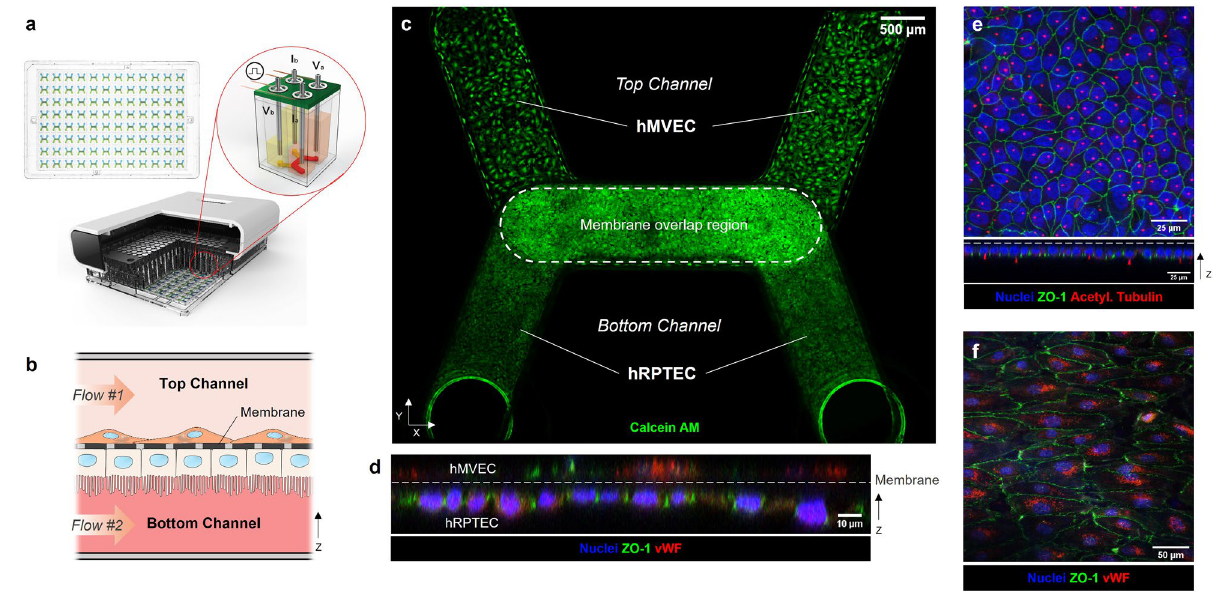
Figure 1. The PREDICT96 platform with integrated TEER sensing supports proximal tubule-microvascular co-culture with in-vivo-like features. ( a ) The PREDICT96 culture plate has 96 microfluidic devices (top left). Cross-sectional rendering of PREDICT96 Integrated TEER system (bottom) highlights the four-point TEER measurement unit (illustration, top right) in which the stainless steel pump tubes double as electrodes. ( b ) A cross-section schematic of the co-culture kidney model in the bilayer microfluidic device with hRPTEC on bottom of the membrane and hMVEC on top of the membrane. Fluid flow is controlled separately in top and bottom channels. ( c ) A confocal tile scan of a PREDICT96 device shows confluent cell layers under high FSS (0.70 dyn/cm 2 ) on day 7 (Calcein AM, green). ( d ) An orthogonal view of a confocal z-stack shows hRPTEC and hMVEC on either side of the device membrane (dashed line) with hRPTEC expressing apical ZO-1 (green) and hMVEC expressing endothelial marker von Willebrand factor (vWF, red). ( e , top) A maximum intensity projection of a z-stack of hRPTEC on the bottom side of the membrane shows continuous tight junctions (ZO- 1, green) and abundant primary cilia (acetylated tubulin, red). ( e , bottom) An orthogonal view demonstrates hRPTEC apical expression of ZO-1 and primary cilia. ( f ) A confocal z-slice of hMVEC on the top side of the membrane shows characteristic punctate expression of vWF (red) and tight junctions